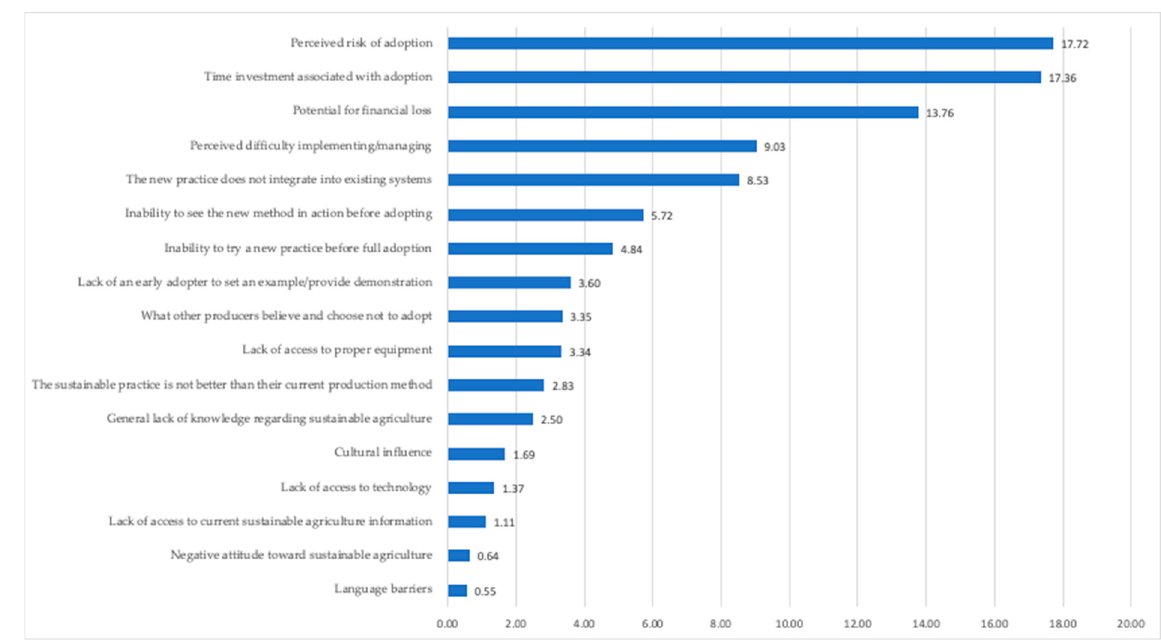
Figure 1. Perceived barriers to adoption BSI analysis.